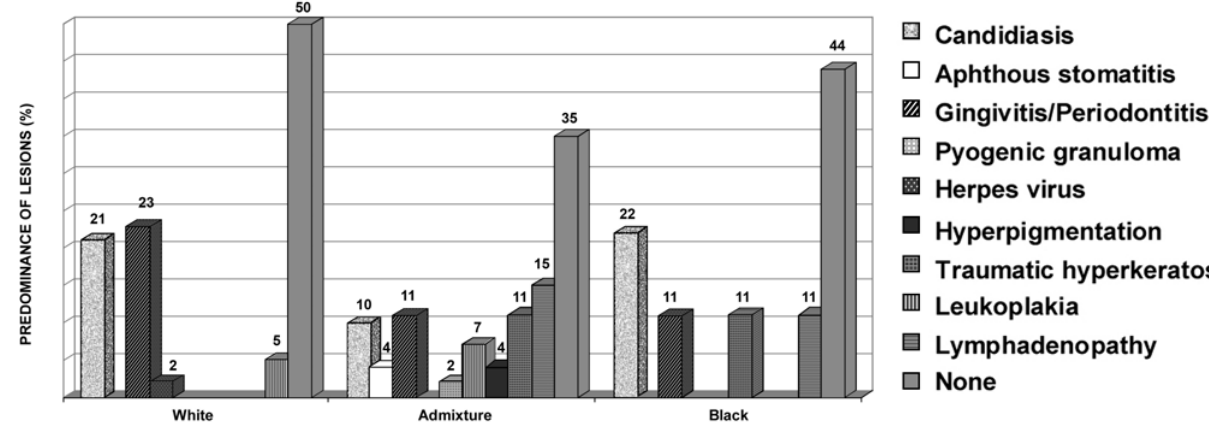
FIGURE 3- Predominance (%) of lesions by